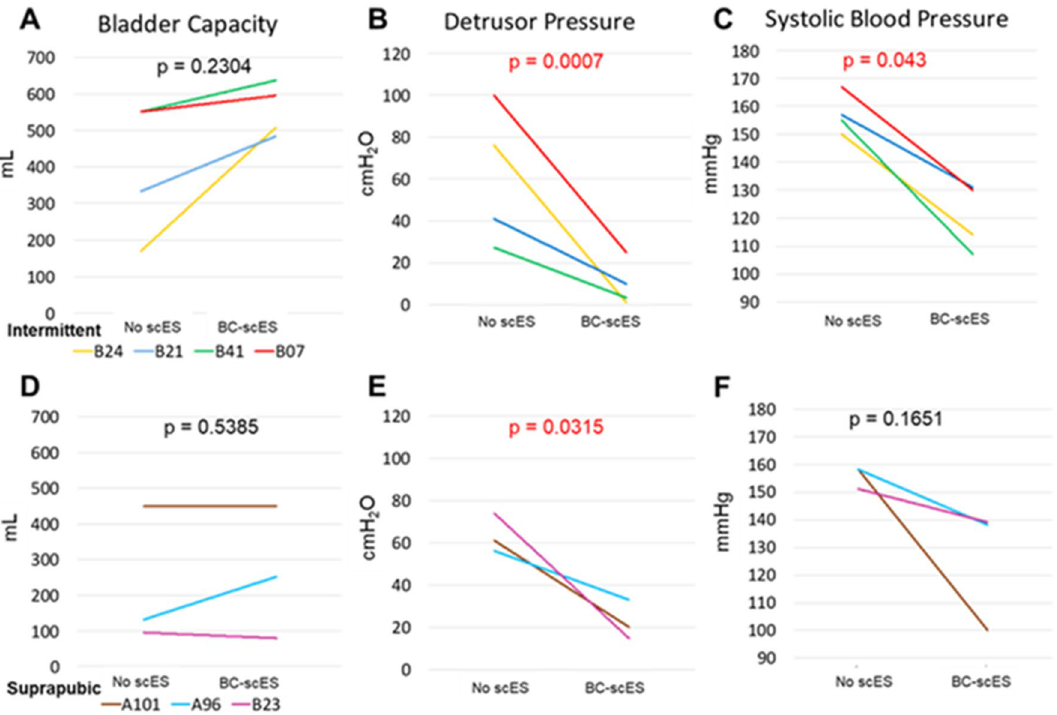
Figure 3. Comparison of bladder capacity, detrusor pressure and systolic blood pressure without scES relative to optimized BC-scES parameters for participants intermittently catheterizing, n = 4 ( A – C ); and participants with a suprapubic catheter, n = 3 ( D – F ). BC-scES mapping significantly improved (reduced) detrusor pressure and systolic blood pressure at maximum capacity in those using intermittent catheterization and detrusor pressure in the suprapubic group.